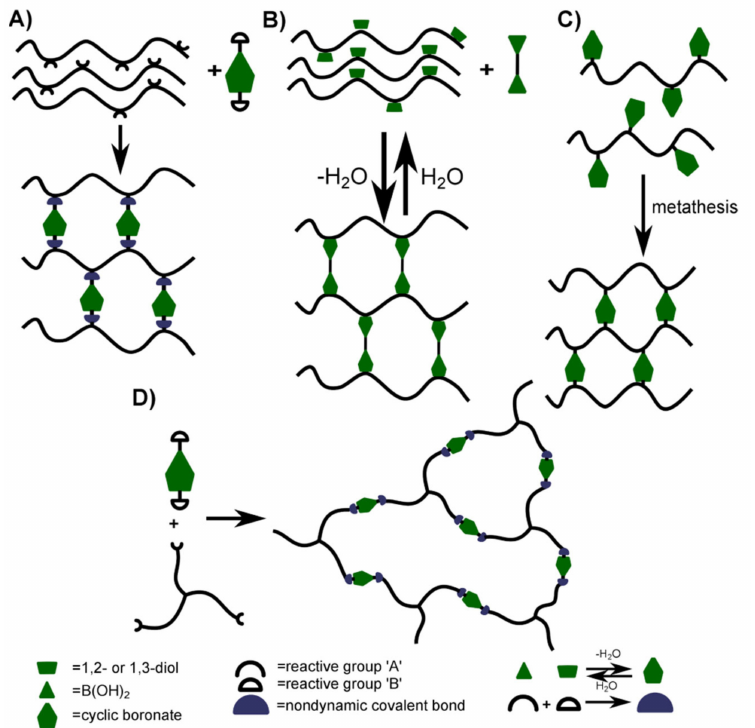
Figure 2. Synthetic strategies for the synthesis of boronic acid esters-based vitrimers. ( A ) cross- linking of macromolecules with cyclic boronates containing reactive groups, ( B ) cross-linking of diol-containing macromolecules with boronic diacids, ( C ) cross-linking of cyclic boronates-containing macromolecules via metathesis, ( D ) reaction between molecules with functionality > 2 and cyclic boronates containing complementary reactive